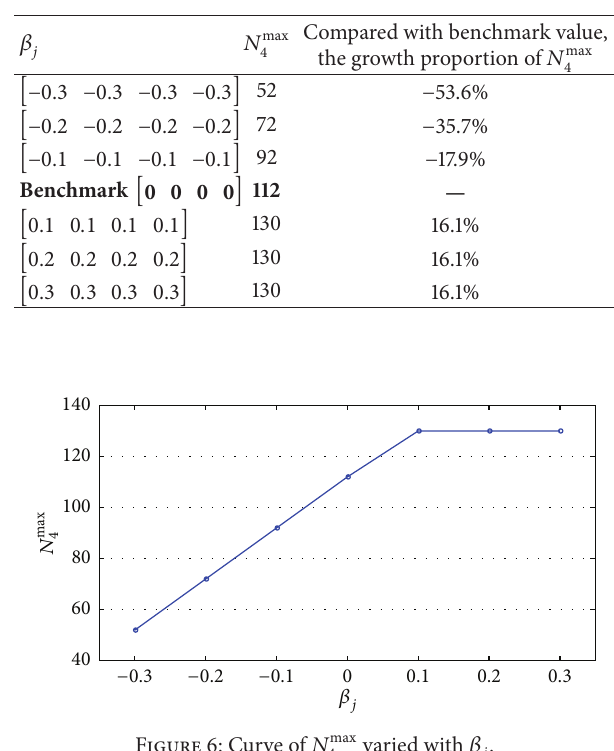
Table 6: Effect of 𝛽 𝑗 on 𝑁 max 𝑗